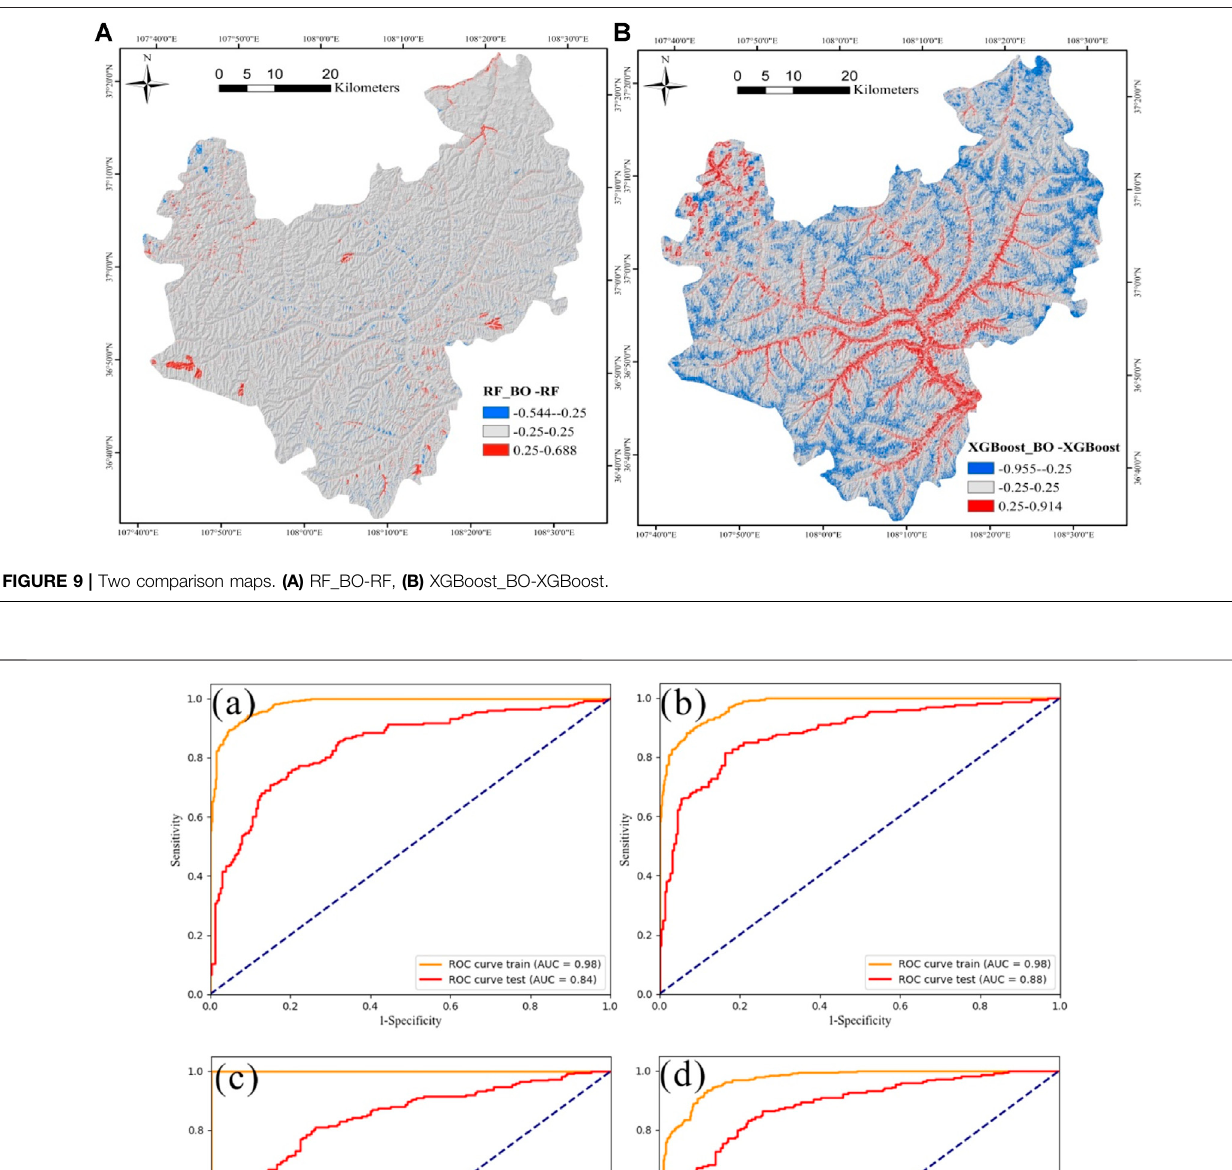
Frontiers in Earth Science |